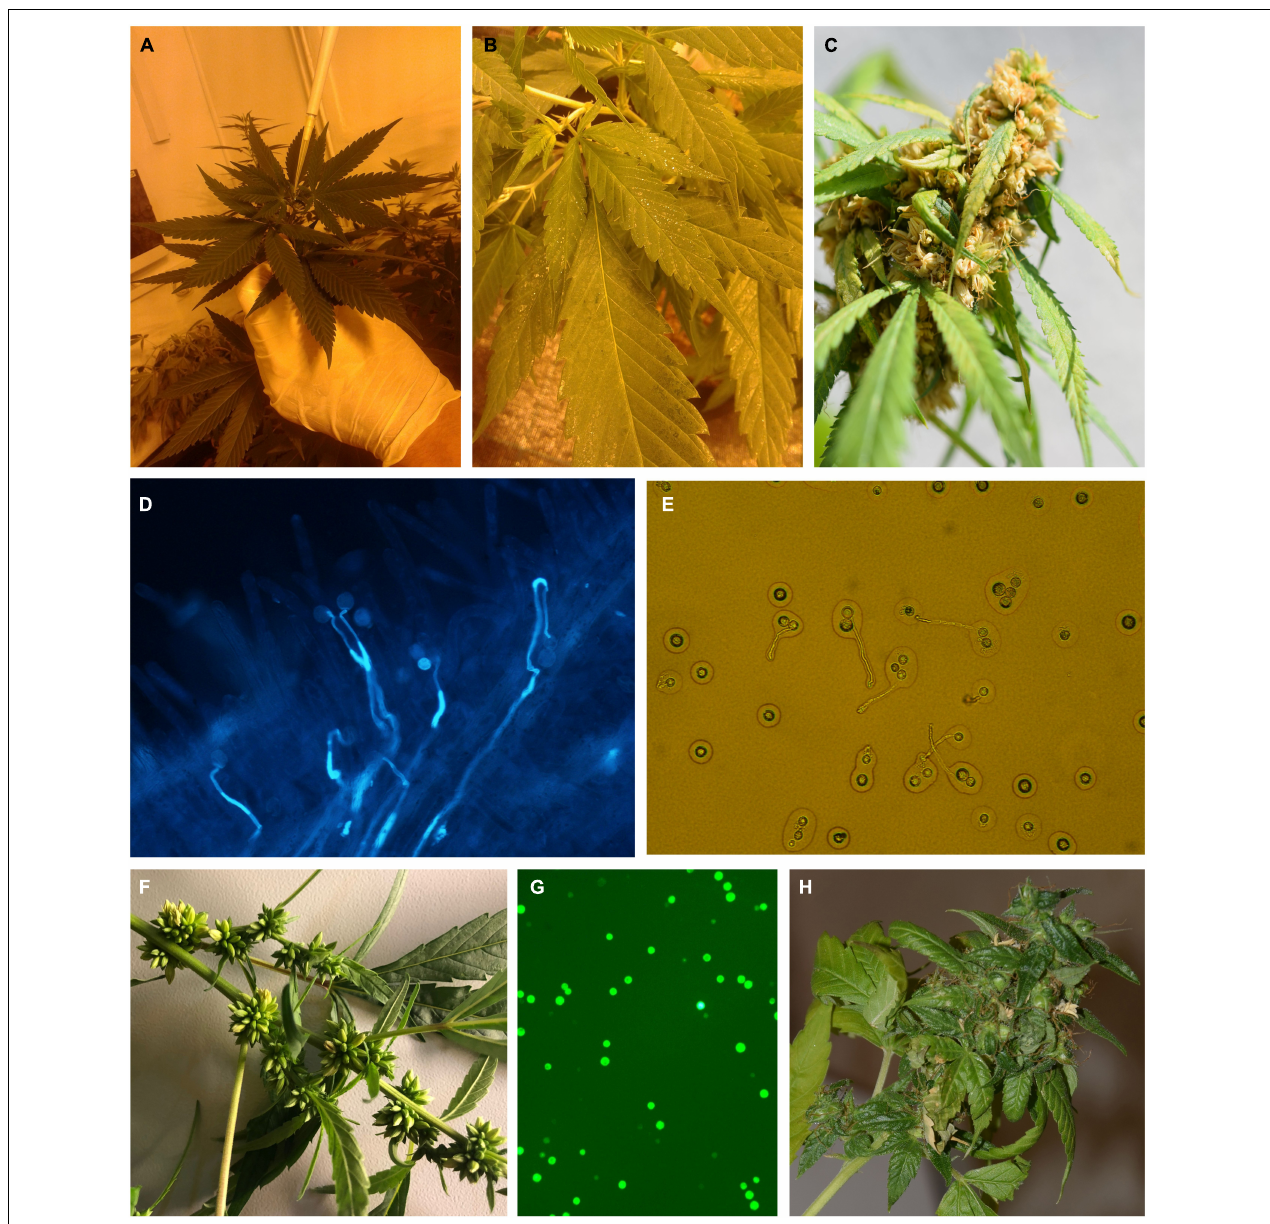
FIGURE 1 | The induction of male flowers on female plants of medical cannabis. (A) Application of silver thiosulfate (STS) on shoot tip. (B) Yellow spots on the leaves 1 week after spraying with 20 mM STS. (C) Male inflorescence at full flowering. (D) In vivo germination of pollen. (E) In vitro germination of pollen. (F) The occurrence of male flowers on female plants of breeding population MX-CBD-707 after spraying with 30 ppm colloidal silver every day. (G) Viable pollen stained with fluorescein diacetate (FDA). (H) Developing seeds after pollination of a control